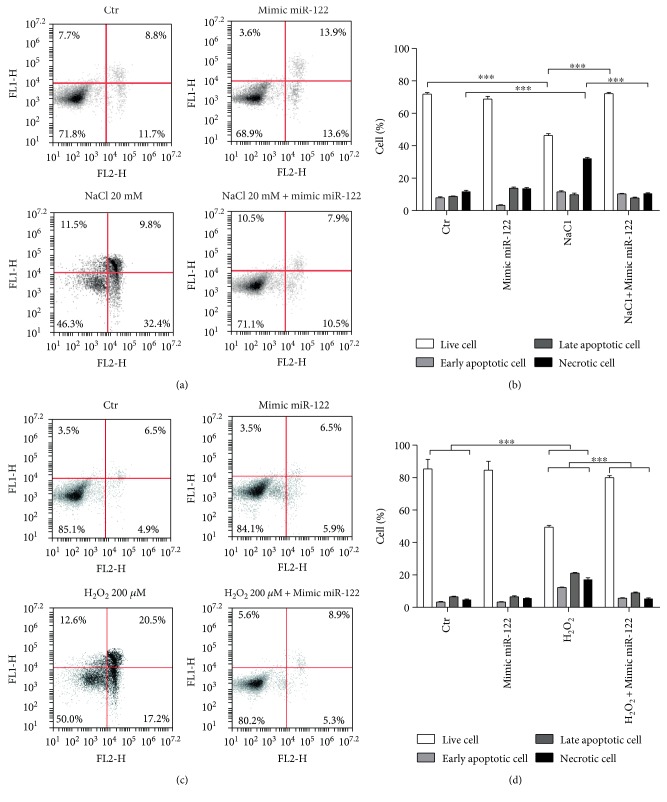
Impact of mimic miRNA-122 overexpression on cell viability, apoptosis, and necrosis in MECs upon exposure to stress stimuli. FACS analysis (a) and corresponding percent values (b) in MECs exposed for 72 hrs to high-NaCl medium (20 mM NaCl) either in the absence or in the presence of mimic miRNA-122 overexpression. FACS analysis (c) and corresponding percent values (d) in MECs exposed for 24 hrs to medium supplemented with 200 μM H2O2 either in the absence or in the presence of mimic miRNA-122 overexpression. Ctr: cells transfected with lipofectamine and miRNA negative control; mimic miR-122: cells transfected with mimic miR-122; NaCl: cells exposed to high-NaCl medium for 72 hrs; H2O2: cells exposed to medium supplemented with 200 μM H2O2 for 24 hrs; NaCl + mimic miR-122: cells transfected with mimic miR-122 and exposed to high-NaCl medium for 72 hrs; H2O2 + mimic miR-122: cells transfected with mimic miR-122 and exposed to medium supplemented with 200 μM H2O2 for 24 hrs. ∗∗∗P < 0.0001 for each comparison.